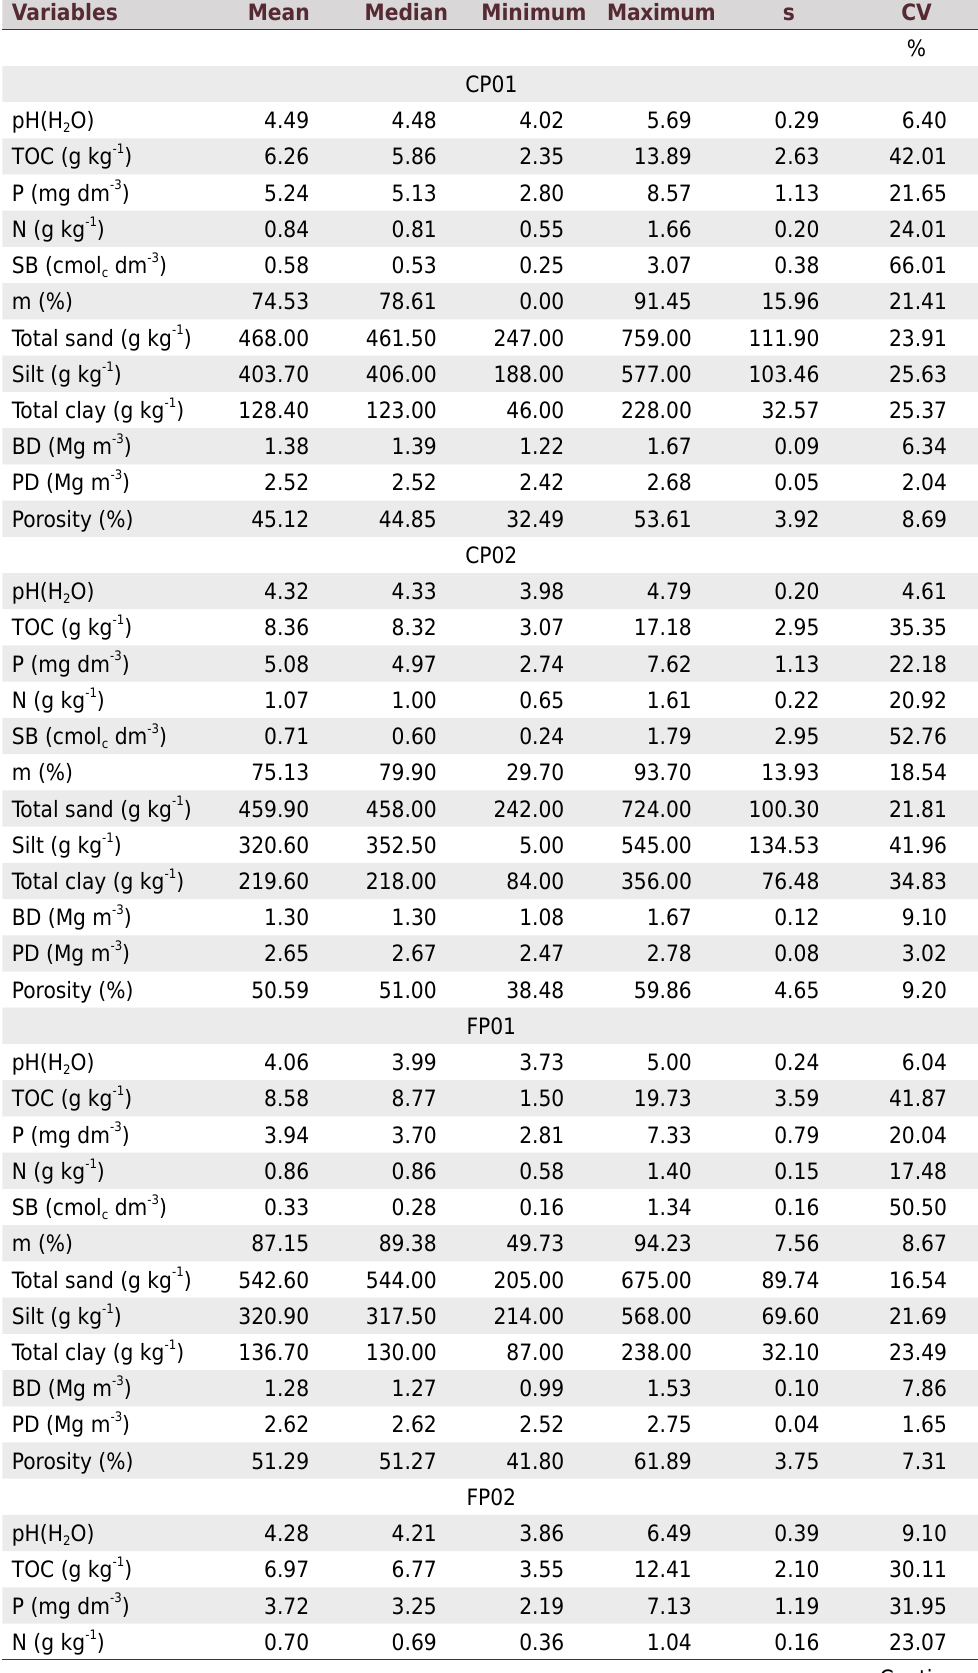
Table 2. Descriptive statistics of soil physical and chemical properties in four plots of 36 ha each, in two native stands of Brazil nut in the state of Acre, Brazil